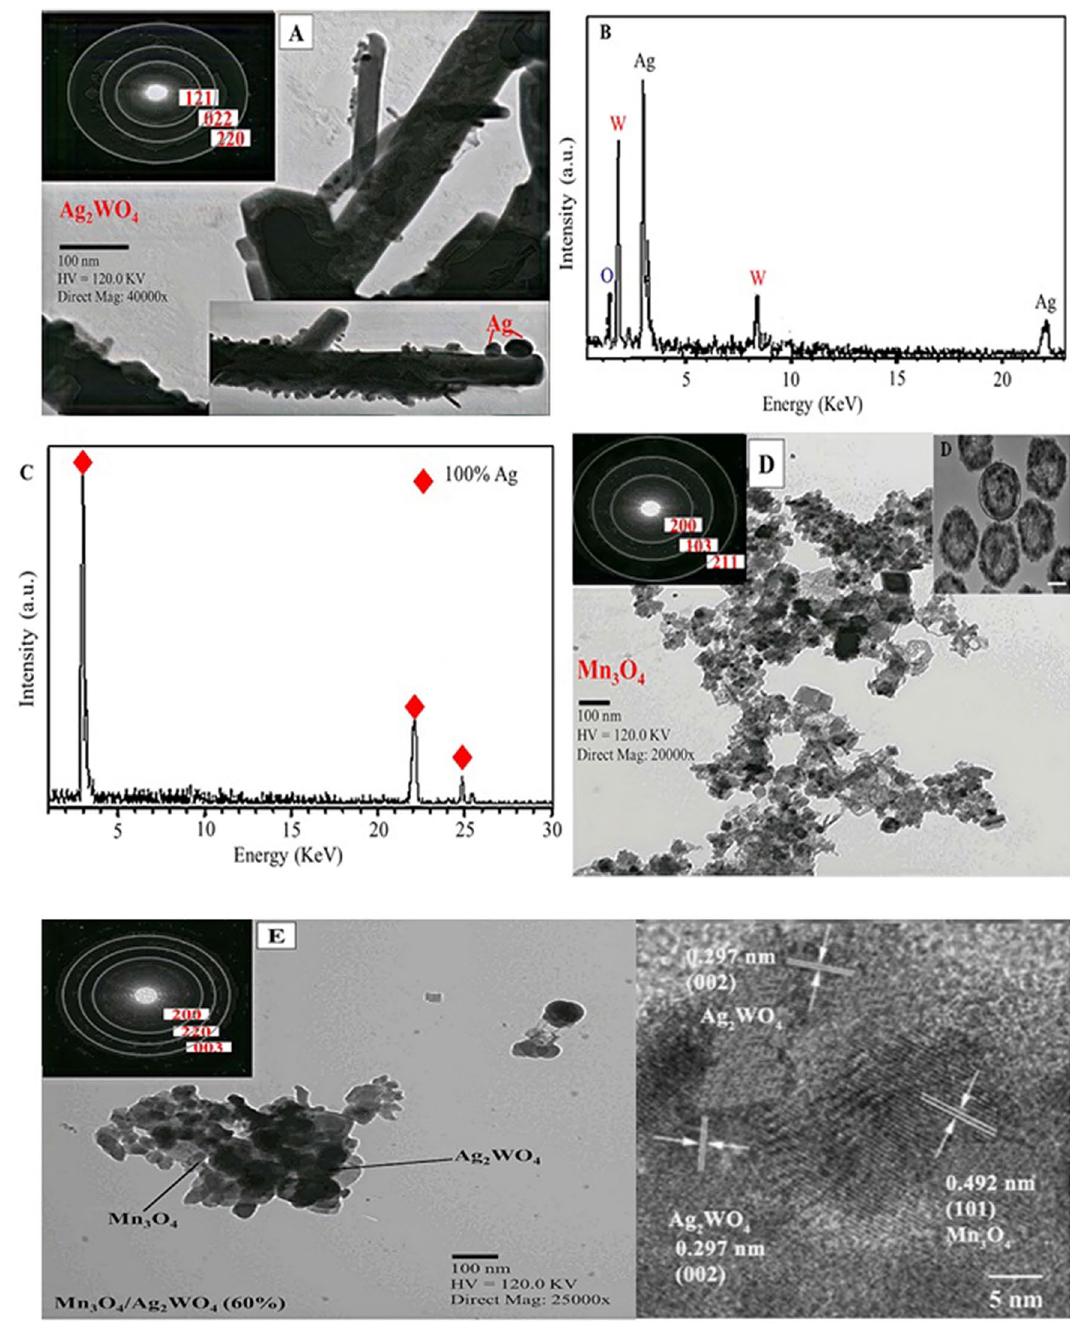
Figure 2. TEM-SAED (inset) images of A ) α-Ag 2 WO 4 , ( B ) EDS spectrum of α-Ag 2 WO 4 , ( C ) EDS spectrum of Ag nanoparticles deposited on α-Ag 2 WO 4 , ( D ) TEM of Mn 3 O 4 and the inset is the HRTEM of hollow Mn 3 O 4 , ( E ) Mn 3 O 4 /α-Ag 2 WO 4 (60%) catalysts and HRTEM image; the scale bar represents 100 nm in all